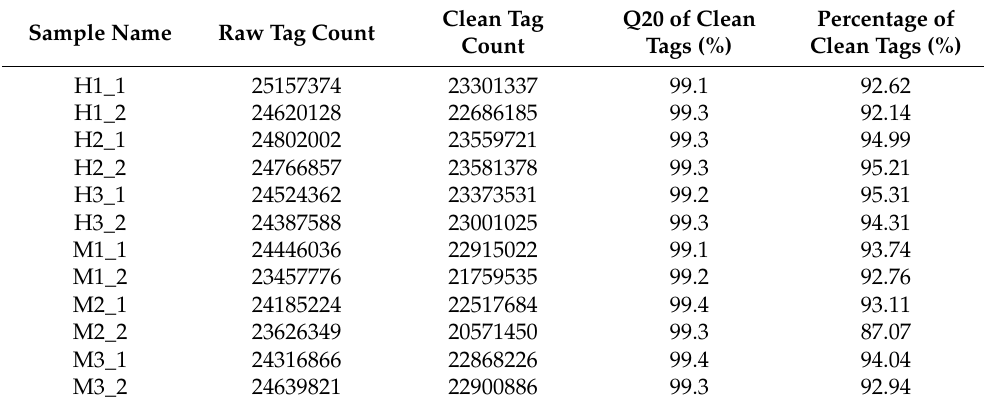
Table 1. Data information for small RNA